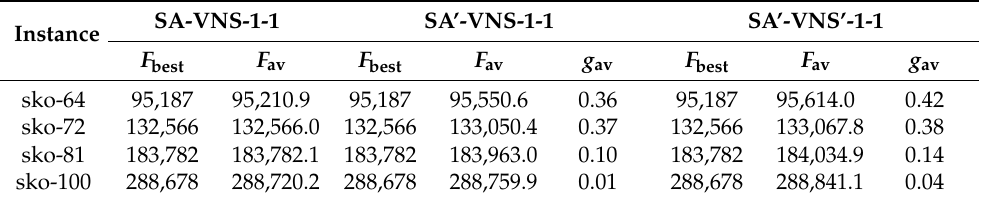
Comparison of different SA-VNS-1-1 versions for the sko instances of the tool indexing